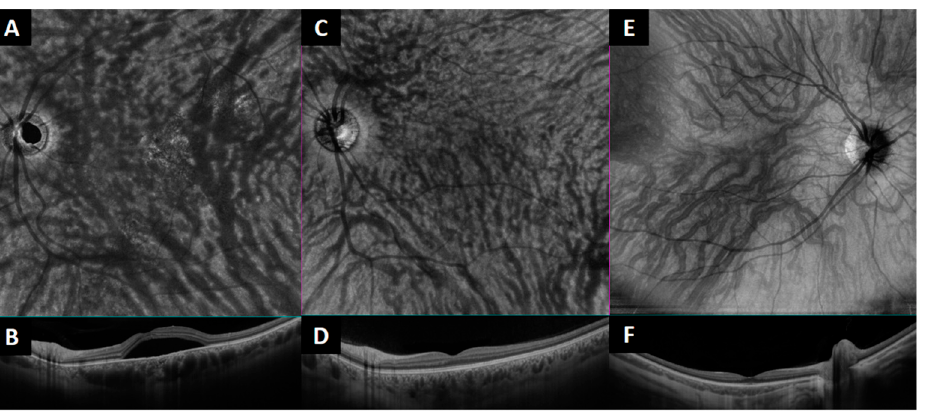
Figure 4. En face optical coherence tomography and the corresponding B scan of the macular region to analyze the presence of intervortex venous anastomosis. ( A , B ): example of an eye affected by central serous chorioretinopathy (CSCR). ( C , D ): Fellow unaffected CSCR eye. ( E , F ): example of a healthy control. Table 2. Results of the kappa value for the inter-rater macular anastomoses assessment.